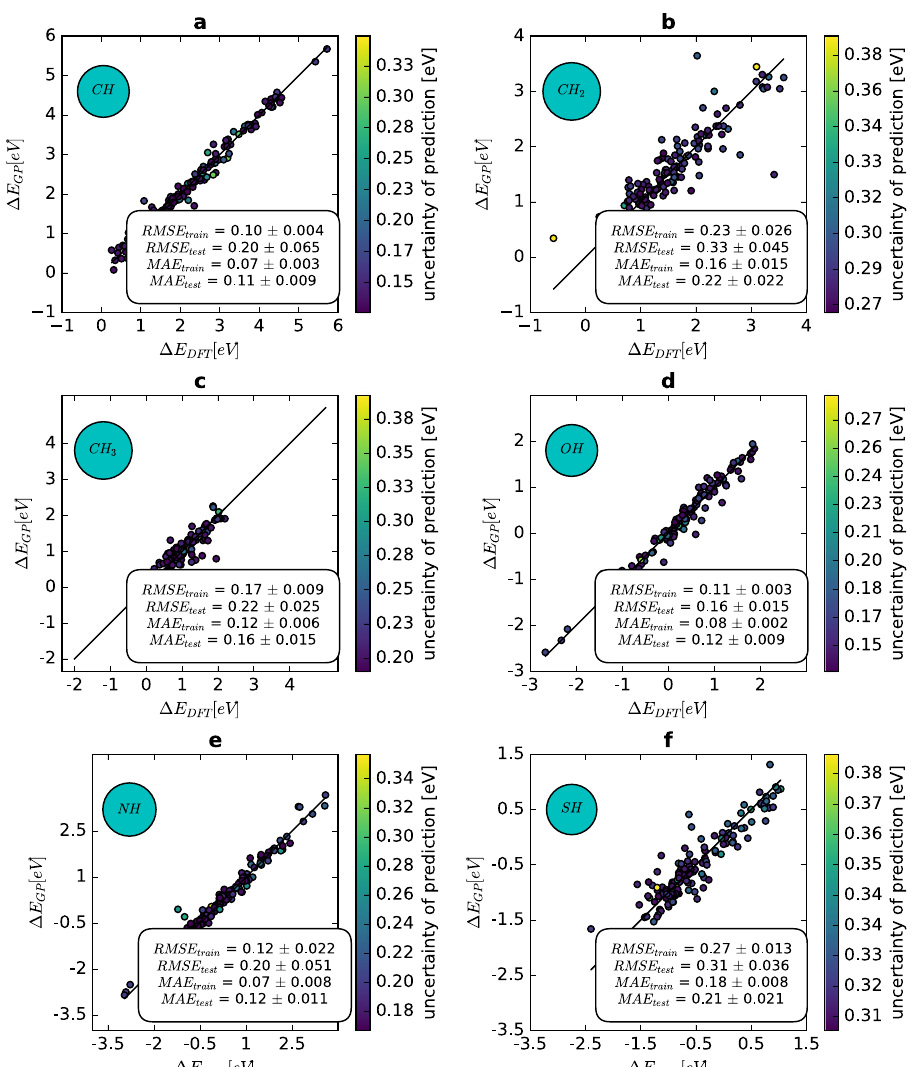
Fig. 6 Parity plot showing the residual learning using scaling relation model predicted Chemisorption energies of AH x plotted against the DFT-computed chemisorption energies for the testing set. a CH *, b CH 2 *, c CH 3 *, d OH *, e NH *, and f SH *. We show the uncertainty in the prediction using a color bar shown in the right bar of each plot.